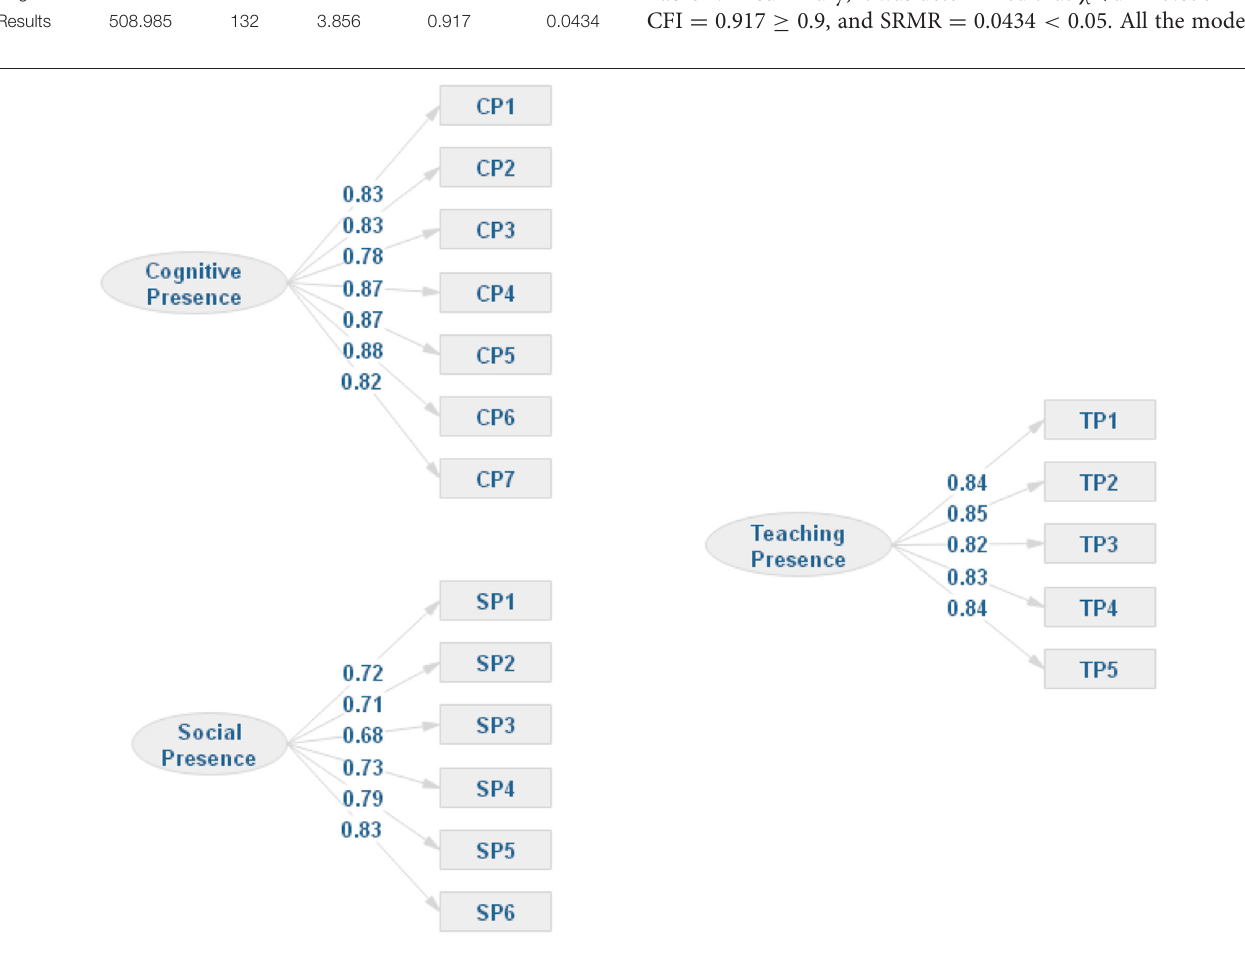
FIGURE 2 | The factor loadings for each measurement